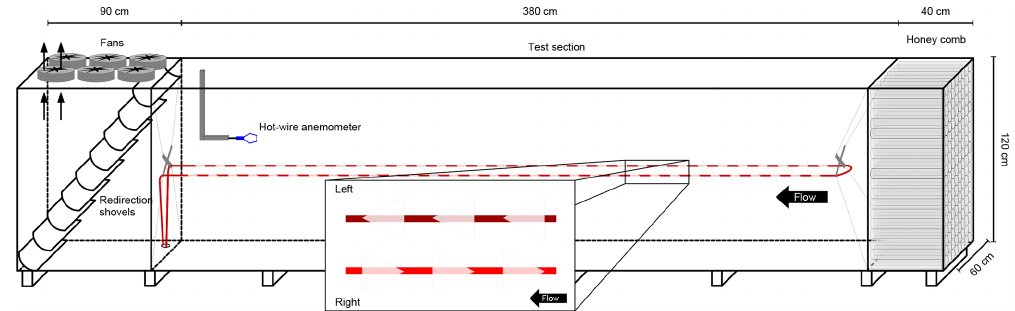
Figure 1. Schematic of the low-speed wind tunnel used to test the microstructure approach to detecting wind direction. The subset highlights the cone orientation relative to the mean flow of the tunnel. The FOC with left-pointing cones is cooler than the FOC with the right-pointing